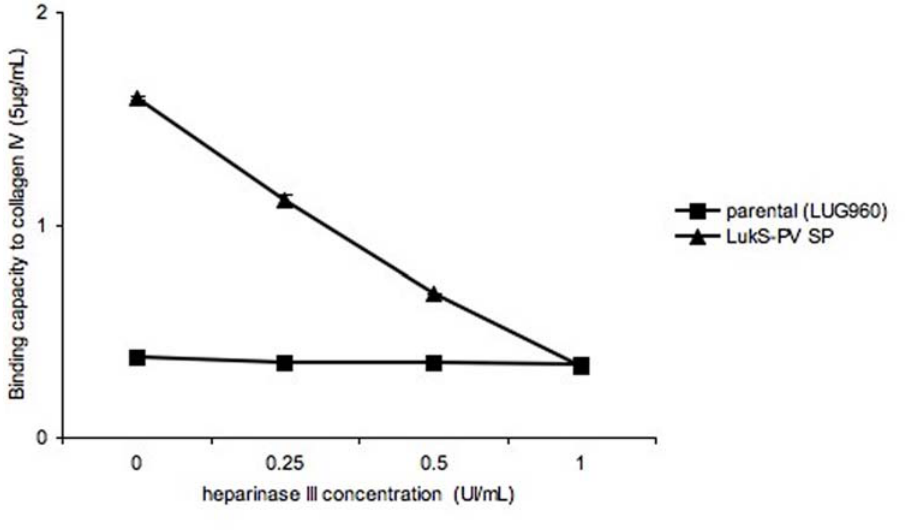
Figure 4. Inhibition of adhesion to collagen IV by heparinase. Isogenic strains of Staphylococcus aureus examined for their binding capacity (Y-axis, absorbance reading at 540 nm) to collagen IV (Sigma) coated on 96-well plates, at concentrations of 5 m g/mL. Heparinase III was added at increasing concentrations (X-axis) to collagen IV (Sigma) before the adhesion assay. Parental (LUG960) indicates the genetic background in which the genetic modifications were made; LukS-PV SP, parental carrying a plasmid encoding the LukS-PV signal peptide. The vertical lines indicate the standard deviations.